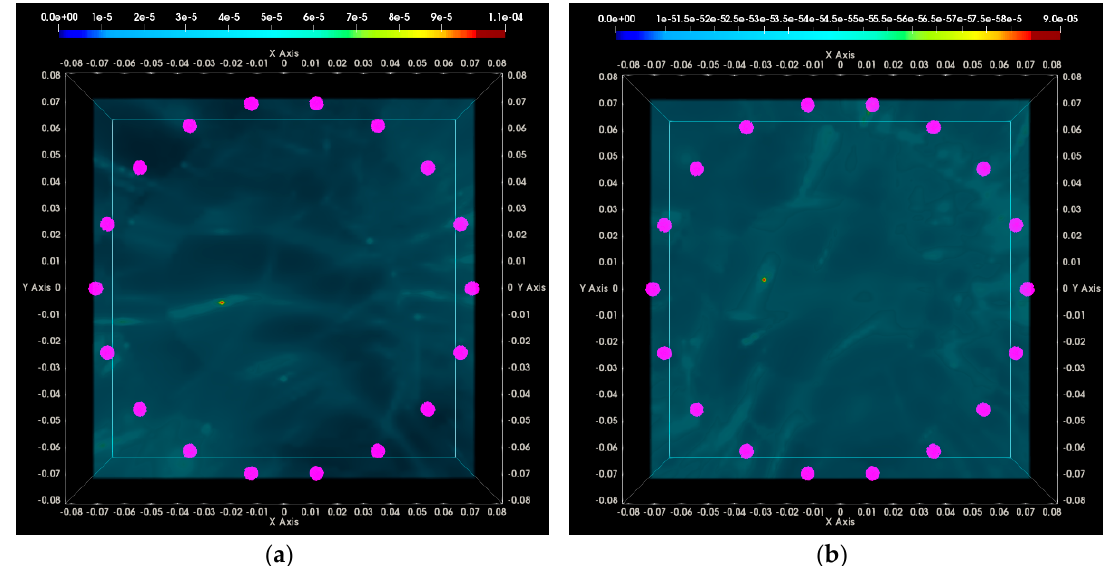
Figure 20. Breast rotational position #2—image formed at a single vertical position of the sensor network, in front of the tumor, top XY view of the full imaging domain (the antennae center positions are depicted with purple spots): ( a ) Test Date 1; ( b ) Test Date 2.